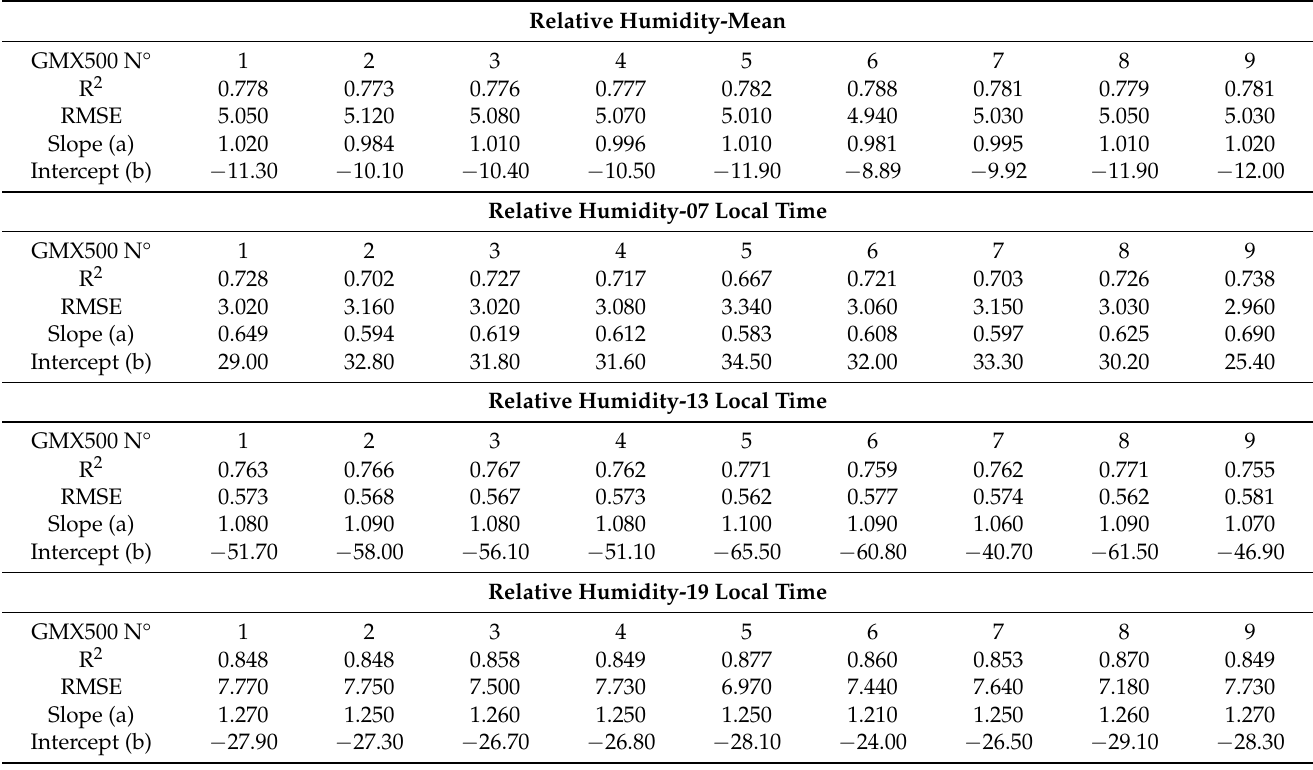
Table A3. Statistical results of the evaluation of relative humidity of the GMX500 sensors with a conventional weather